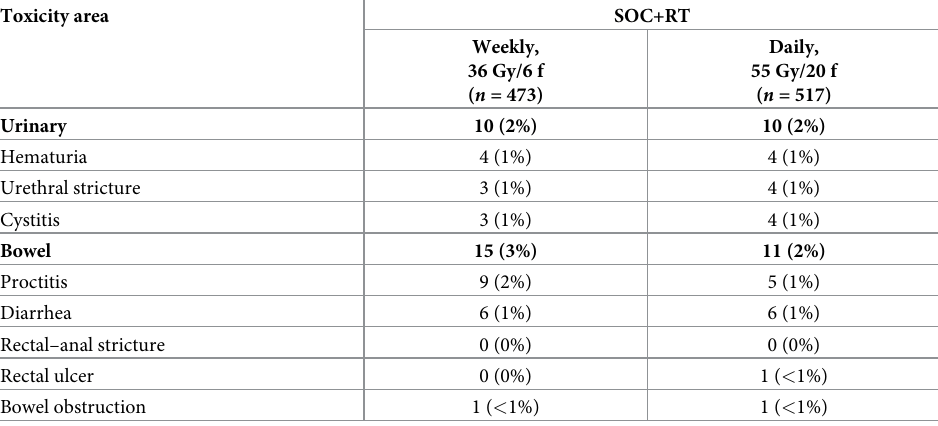
Table 4. Patients with grade 3/4 worst late RT toxicity score reported over entire time on trial. Toxicity area